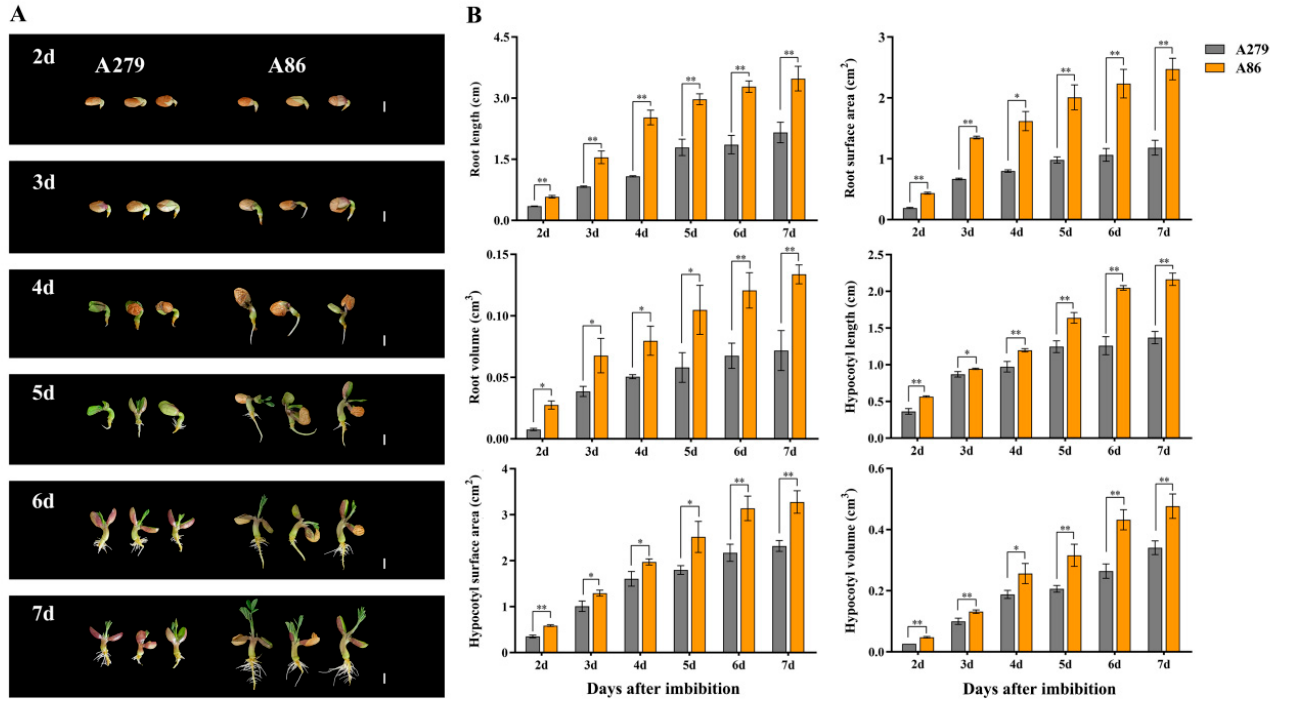
Figure 1. A comparison of the seed vigor between A86 and A279. ( A ) Phenotypes of root growth and hypocotyl elongation of A86 and A279 from 2 to 7 days. ( B ) Changes in root length, root surface area, root volume, hypocotyl length, hypocotyl surface area, and hypocotyl volume of A86 and A279 from 2 to 7 days. For statistical analysis, three independent experiments were conducted, each with three replicates (25 seeds for each replicate). Differences between A86 and A279 at each time point were analyzed by the Student’s t -test. * and ** indicate significant differences at p < 0.05 and p < 0.01, respectively.